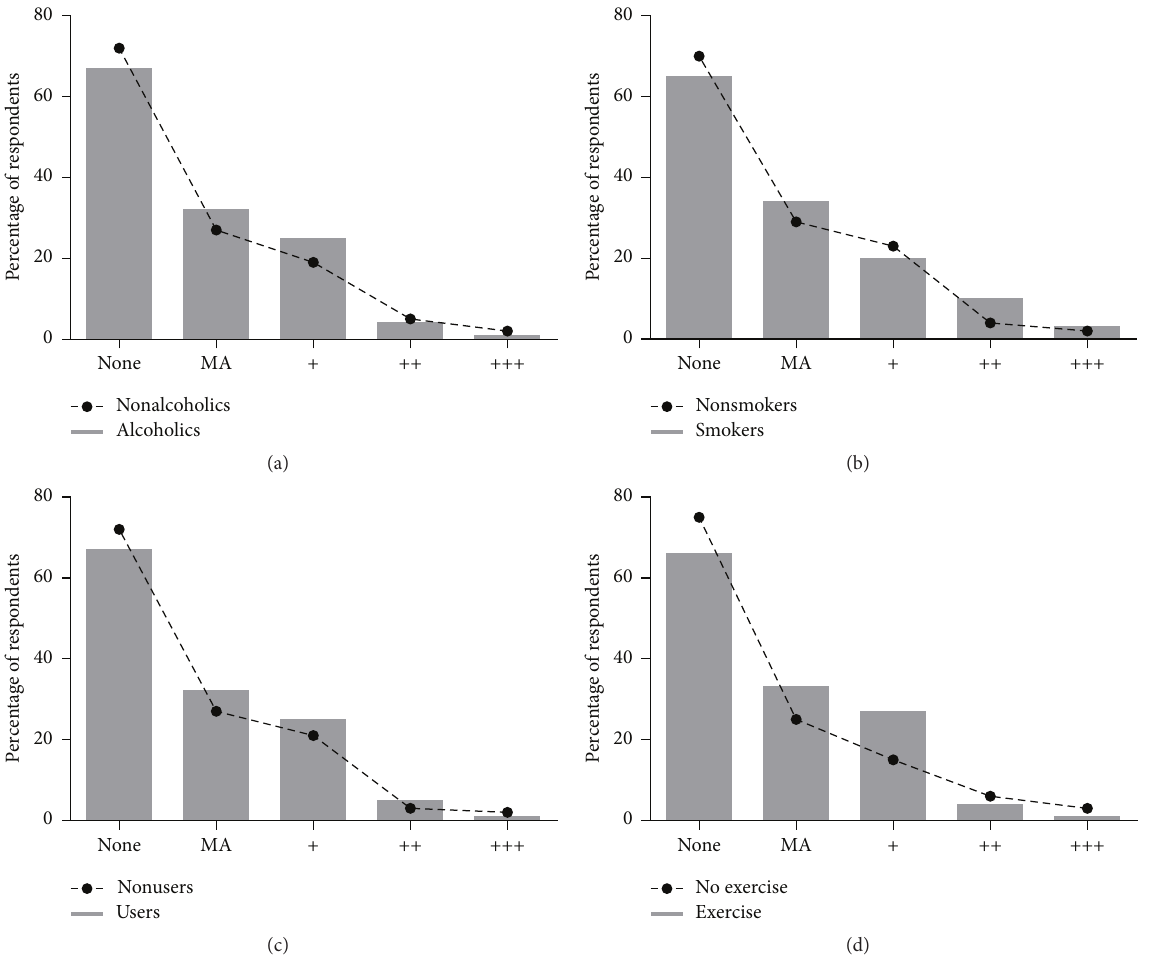
Figure 4: Prevalence of microalbuminuria among hypertension subjects stratified by sociodemographic characteristics. MA: microalbumin- uria. (a) Alcohol intake, (b) smoking status, (c) herbal medicine intake, and (d) physical activity